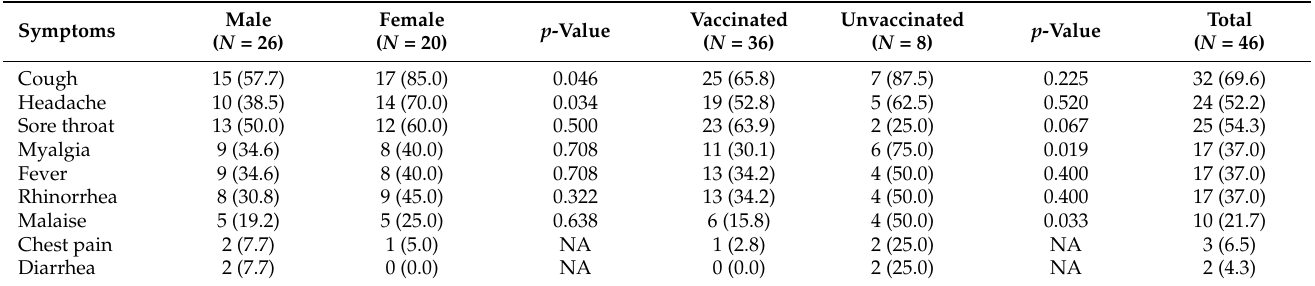
Table 2. Analysis of the presenting complaints according to sex and vaccination